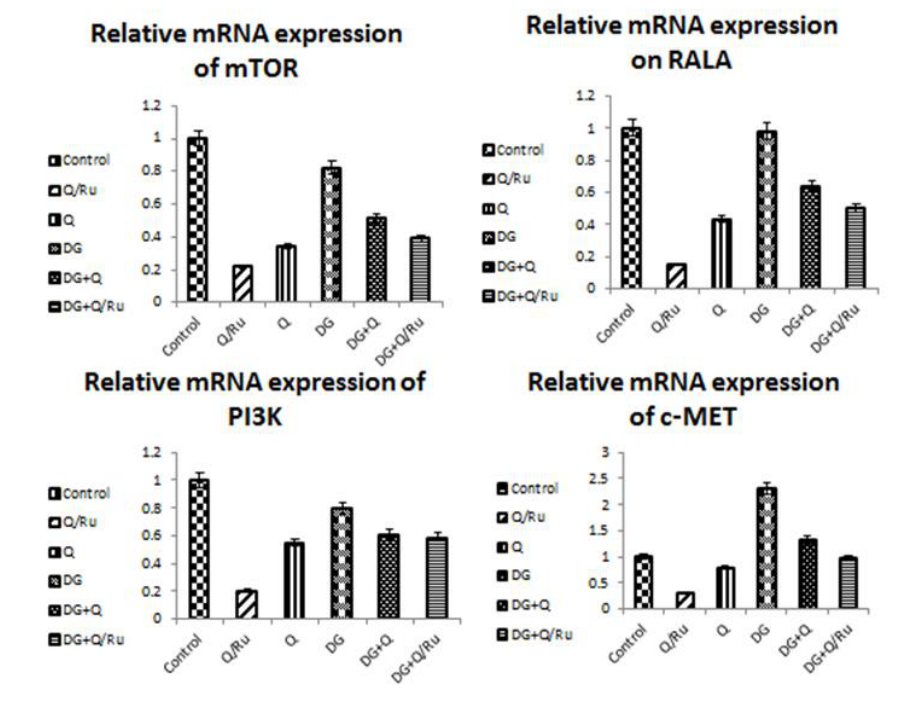
in MDA levels compared to the control group. The best results were recorded in the last group of treatment with Ru III /Q.